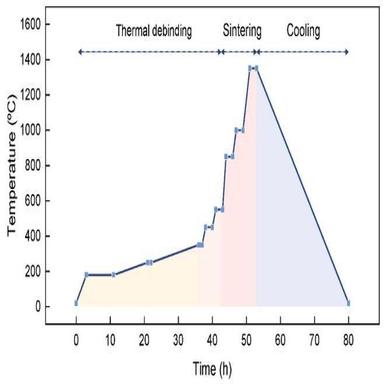
Temperature profile for the thermal debinding, sintering, and cooling process of 3D printed binder-coated zirconia.